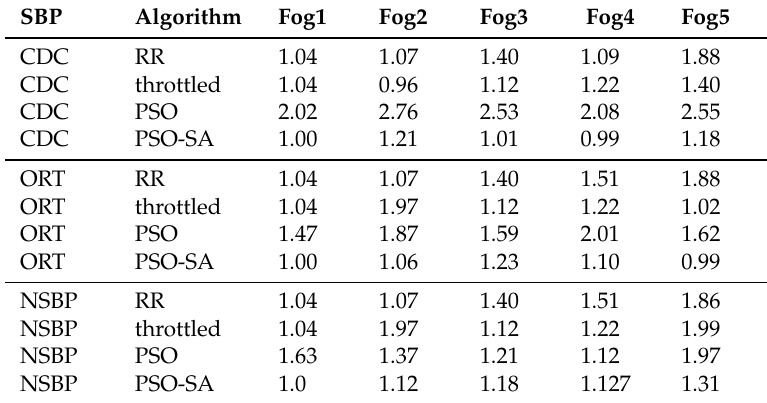
Table 4. Average PT (ms) of Scenario